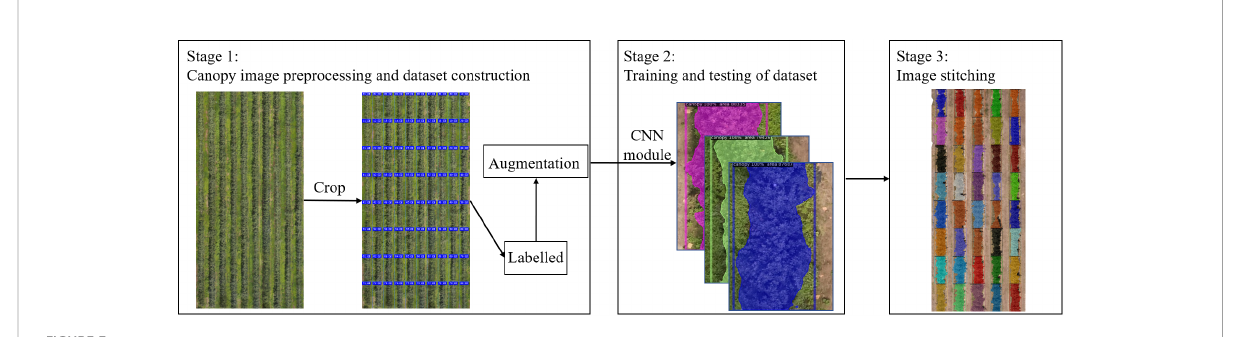
FIGURE 3 Canopy segmentation